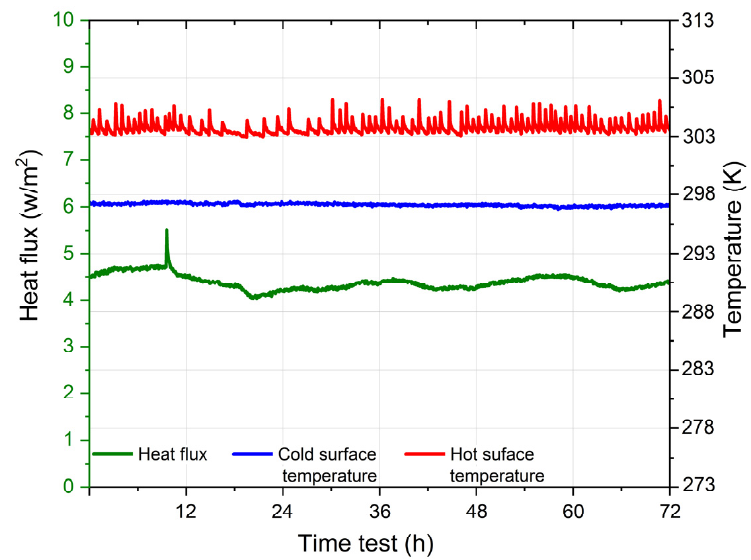
Figure 6. Hotbox test results for giant-reed board II-50.